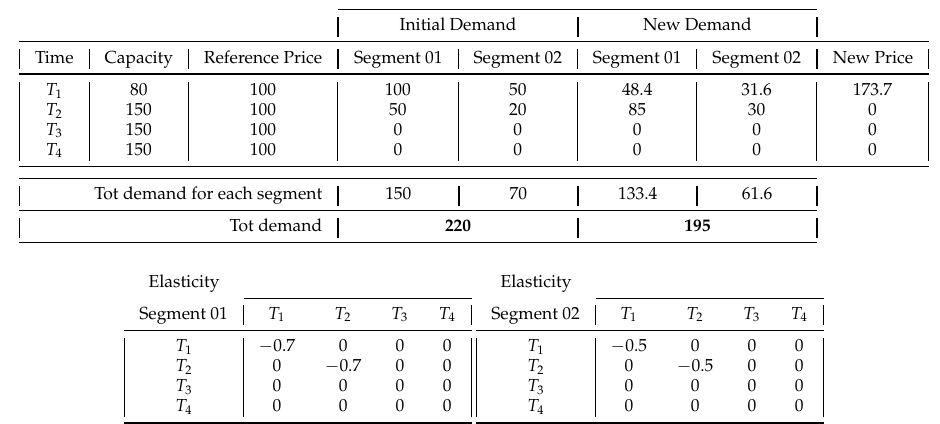
Table 3. Case Study 6.01—second sub-case, data, and results.